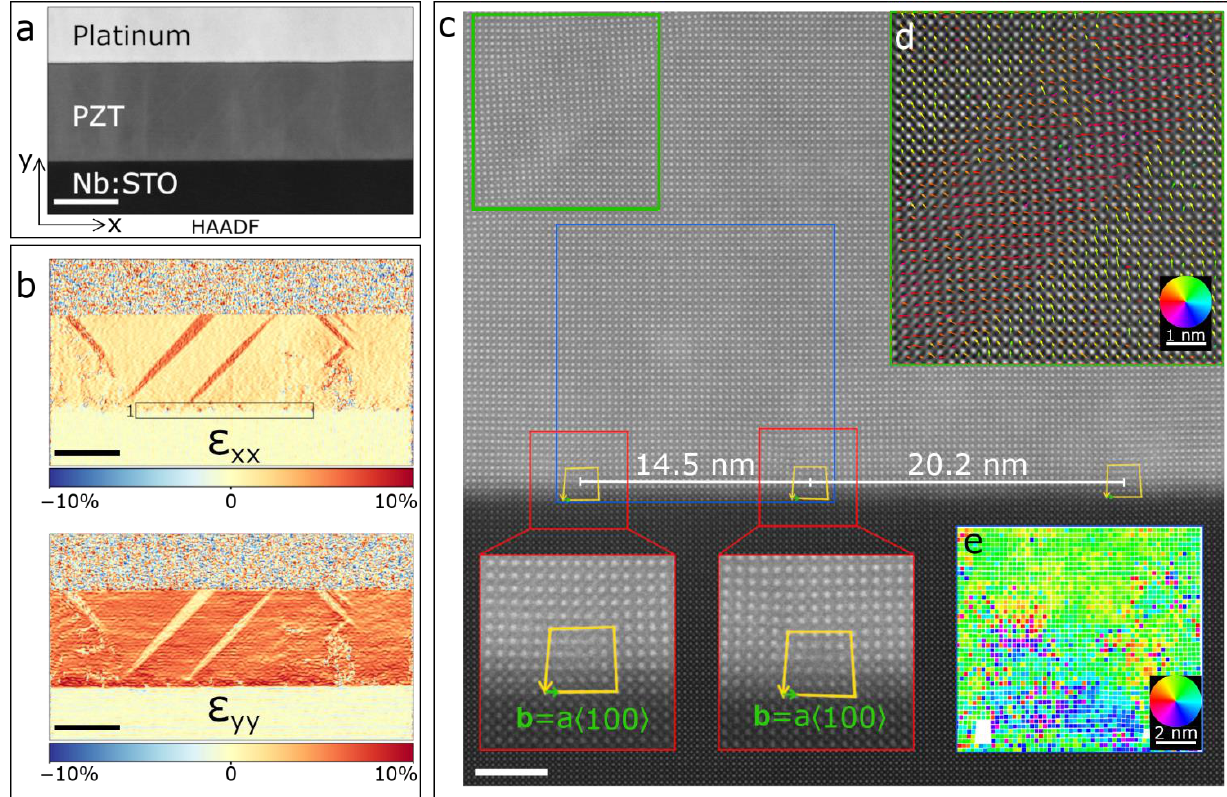
Figure 3. ( a ) HAADF-STEM image of the PZT thin film grown on Nb:STO and Pt electrode. ( b ) Relative strain maps along x- and y-directions calculated by geometric phase analysis (GPA) of the HAADF-STEM image shown in ( a ). The substrate was used as zero strain reference. Area 1 highlights a row of misfit dislocations at the PZT/Nb:STO interface. ( c ) Atomic resolution HAADF-STEM image showing a row of dislocations at the interface and a section of a needle-like domain at the top left corner. Magnified views of the dislocations with the Burgers circuits and resulting Burgers vector are shown at the bottom. ( d ) Polarization map superimposed to the ferroelastic needle-like domain showing the polarization rotation, calculated from the atomic displacements of the Ti ions with respect to the 4 neighboring Pb ions. The color and size of the arrows correspond to the direction and magnitude of the polarization, respectively. ( e ) Map of the polarization direction of the region comprising the two dislocations on the left side (blue rectangle). A region near the bottom interface with reversed (downwards) polarization is clearly observed in blue color. Scale bars in ( a , b ) are 50 nm and in ( c ) 5 nm,